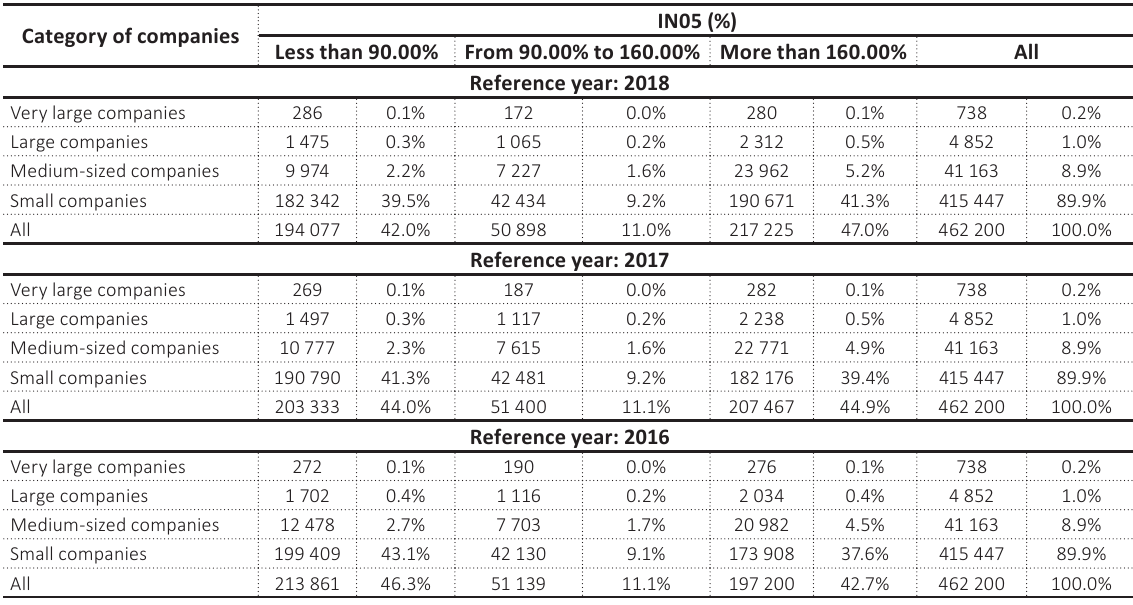
Source: Own tests based on company data from Amadeus.